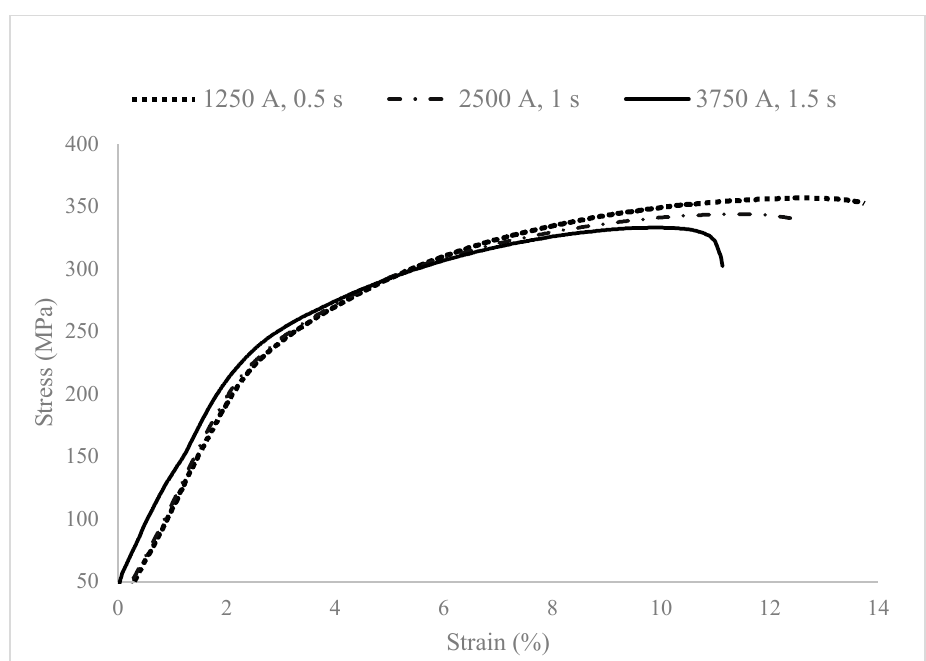
Figure 16. Stress–strain diagram obtained from shear tensile test of samples welded by RSW method.